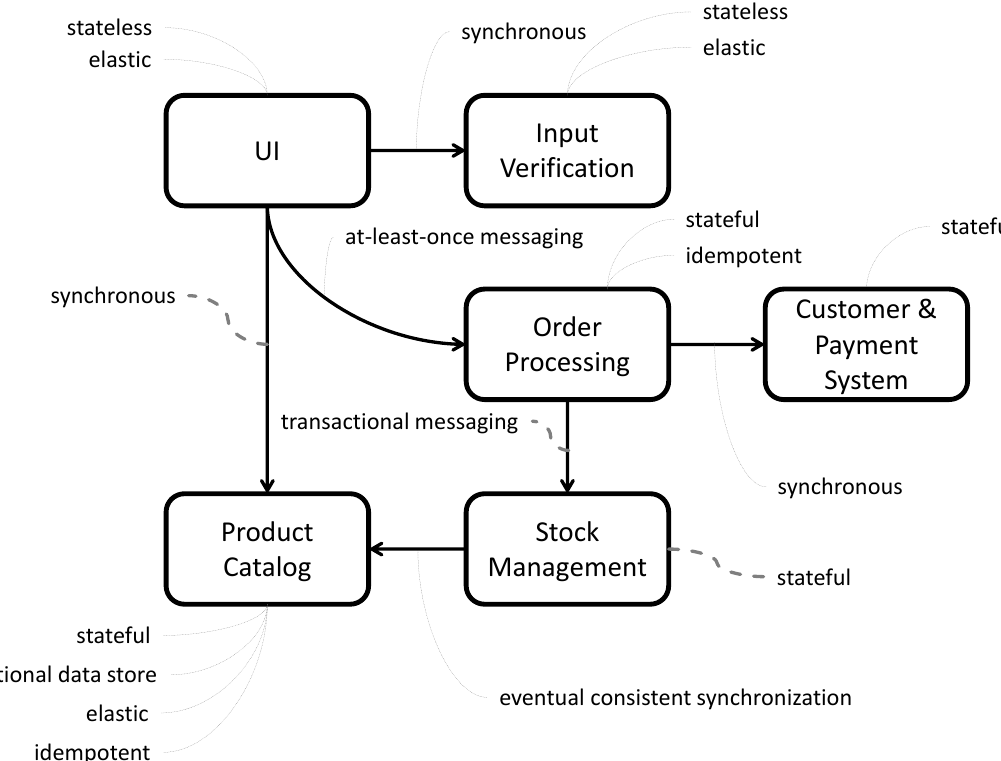
Figure 19. Enriched Diagram of the Web Shop